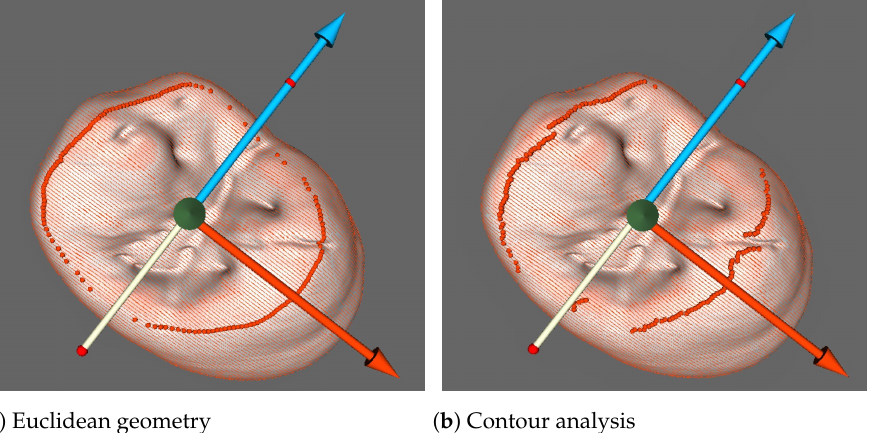
Figure 6. 3D view of occlusal surface border landmarks (red dots) set according to Euclidean geometry rules ( a ) and surface contour analysis ( b ); upper right first premolar, S2; 100 section